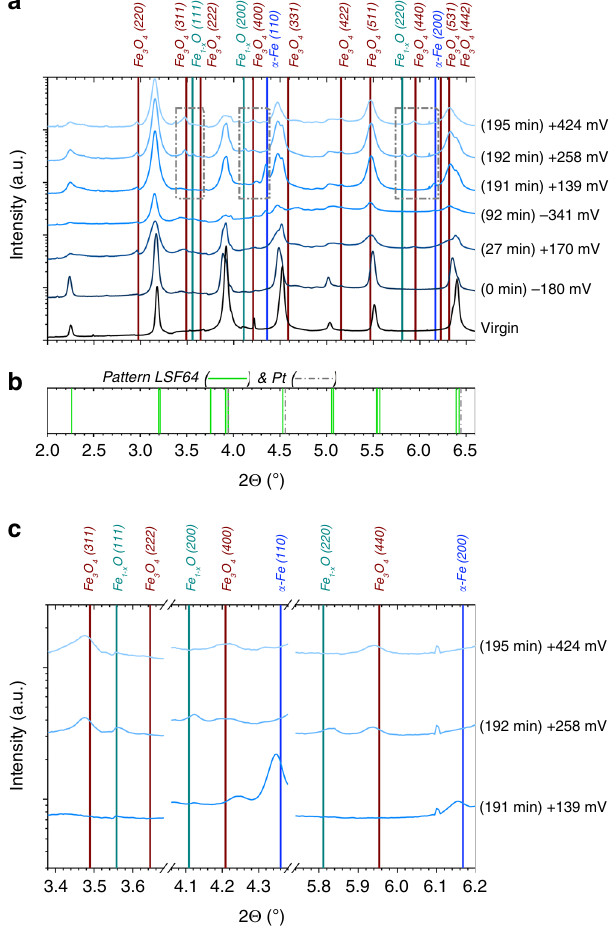
Fig. 5 1D diffraction pattern obtained by integrating the entire 2D pattern in Fig. 2 and Supplementary Fig. 4. a The vertical lines indicate the expected re fl exes of bcc iron ( α -Fe, pdf# 04-014-0360), Fe 1-x O (pdf# 01- 079-2175), and Fe 3 O 4 (pdf# 01-080-6410) 31 . The dashed boxes indicate zoom regions. Please note that the scale of the intensity axis is logarithmic. b Literature pattern of rhombohedral La 0.6 Sr 0.4 FeO 3- δ . (pdf# 00-049- 0285) and platinum (pdf# 00-004-0802) 31 . c Zoom of the dashed boxes from ( a